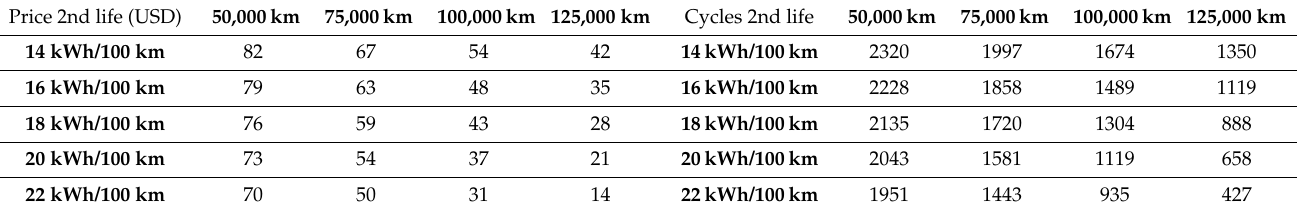
Table 7. Sensitivity analysis-the price of the 2nd battery life.